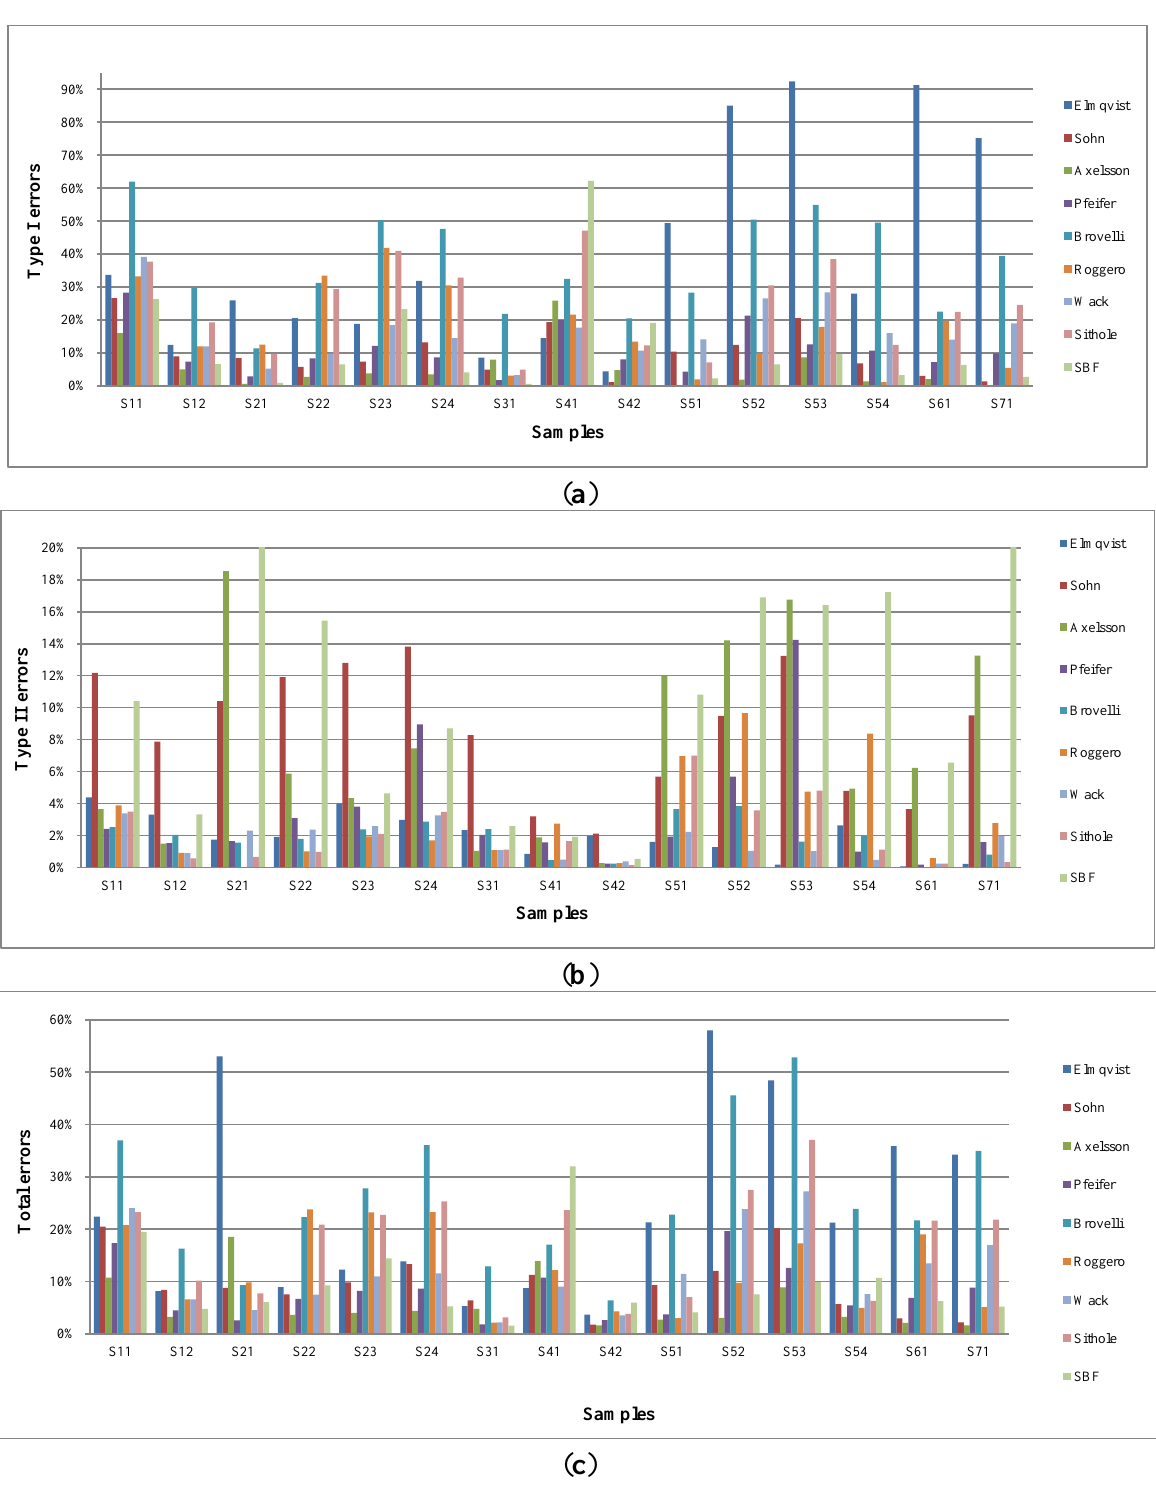
Figure 15. Comparison of the three types of errors for the SBF method and the eight methods in [17]: ( a ) Type I errors of different algorithms for the samples; ( b ) Type II errors of different algorithms for the samples; ( c ) Total errors of the two algorithms for the samples. Note “S” is abbreviation of “Sample” for the horizontal